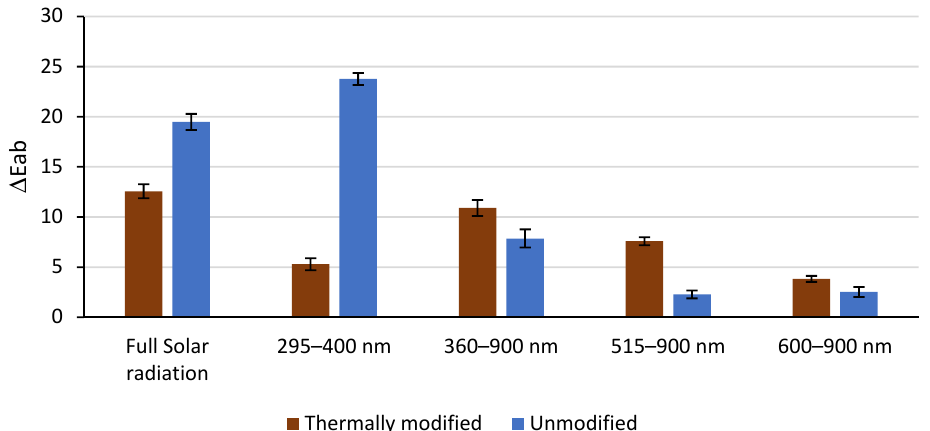
Figure 3. Discoloration ∆ E ab of unmodified and thermally modified wood caused by wood expo- sure to full solar radiation and to solar radiation through glass filters transmitting definite wave- length ranges.